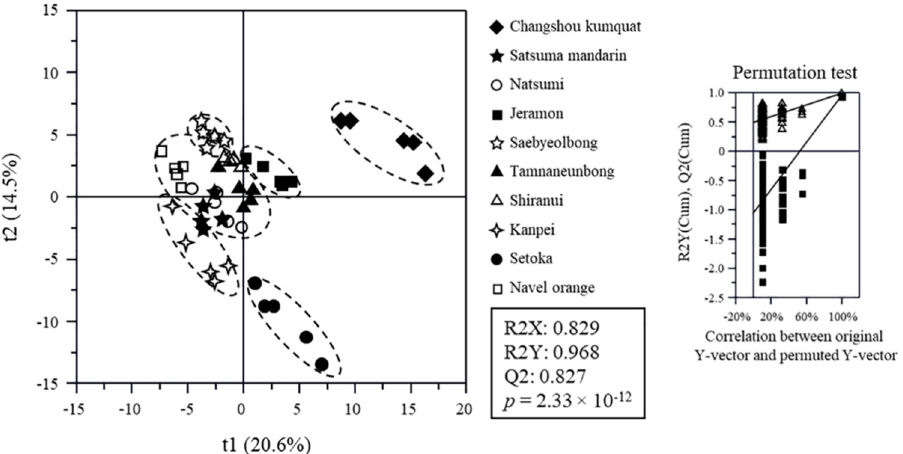
Figure 2. Partial least-squares discriminant analysis (PLS-DA) score plot of citrus metabolites ana- lyzed using gas chromatography-mass spectrometry, ultra-high performance liquid chromatography- quadrupole time-of-flight mass spectrometry, and high-performance liquid chromatography with its qualifying parameters. The qualification of the PLS-DA model was evaluated using R2X, R2Y, Q2, and p -value and validated using cross validation with a permutation test ( n = 200).